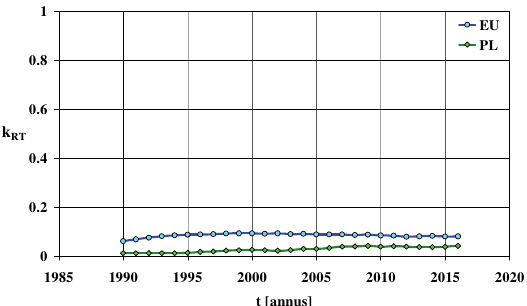
Fig. 16. Share of annual emission from motor vehicles comparing to the total annual emission for total suspended particles: in Poland – PL and in